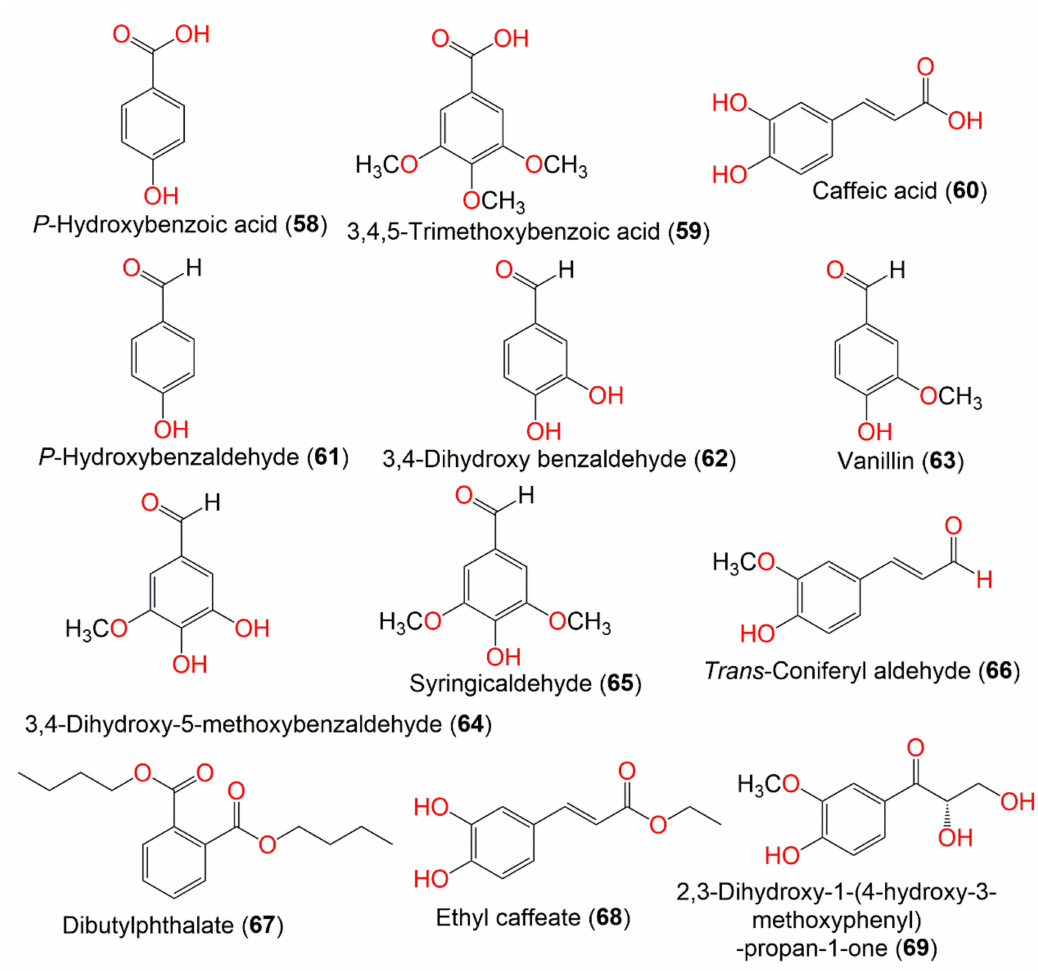
Figure 7. Structures of compounds 58 – 69